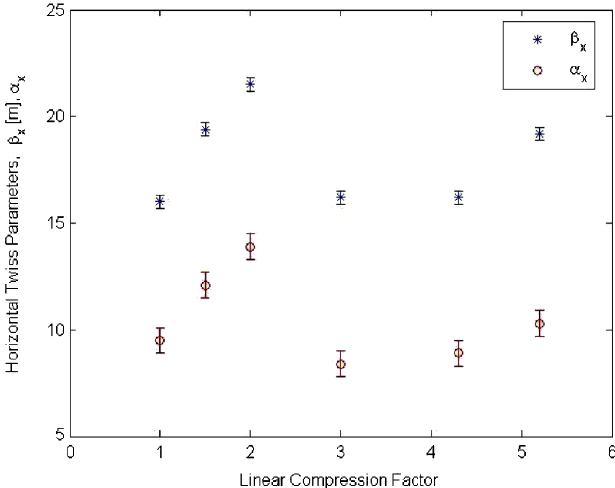
FIG. 11. Beam horizontal Twiss parameters (red circle marker , black star marker for (cid:4) ) measured as a function of the for (cid:10) x x compression factor. This is varied by keeping BC1 at the fixed bending angle of 85 mrad and by varying the L1 rf phase.